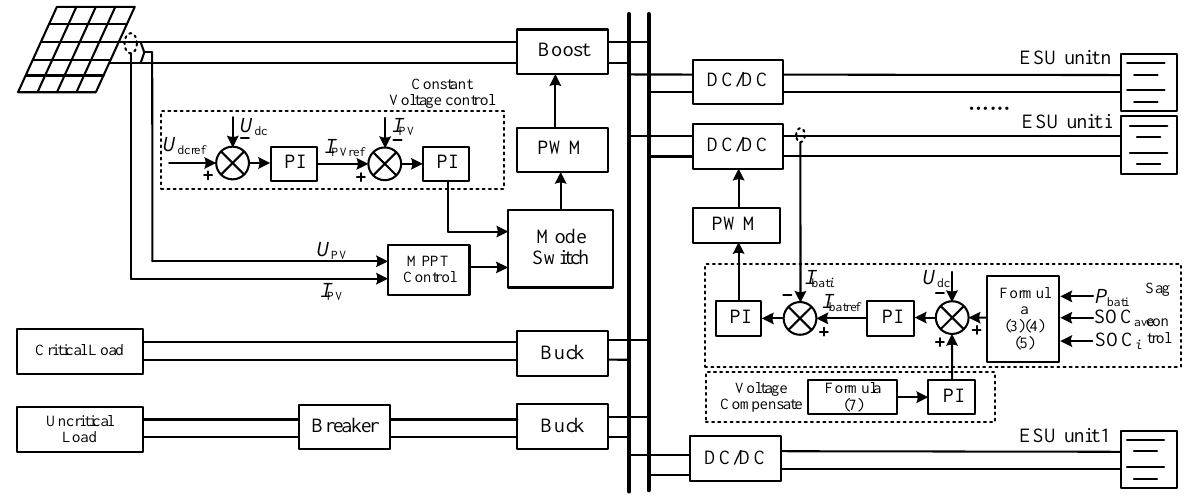
Figure 6. DC microgrid and its control structure.